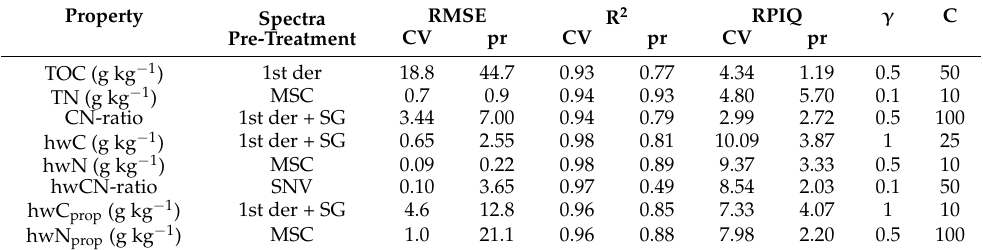
Table 4. Calibration ( n = 114) and validation ( n = 48) parameters and kernel function hyperparameters gamma ( γ ) and cost (C) of SVM models for the prediction of compost and BCS and associated psc’s via portable MIRS (pMIRS) (CV = cross validation, calibration; pr = prediction, test set validation). Property Spectra RMSE R 2 RPIQ γ C CV pr CV pr CV pr Pre-Treatment TOC (g kg − 1 ) 1st der TN (g kg − 1 ) MSC hwN (g kg − 1 ) MSC hwN prop (g kg − 1 ) MSC 1.0